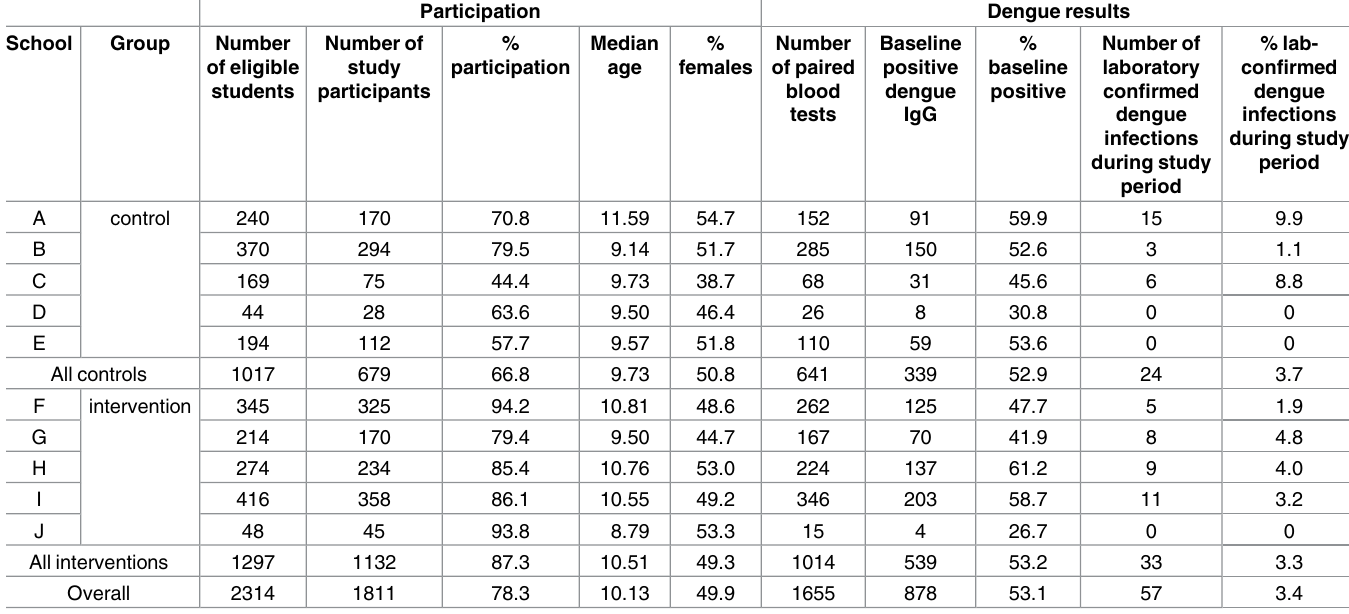
Table 1. Proportions of dengue infections in 1,655 Thai school children with paired serum samples at 10 schools randomised to insecticide- treated school uniforms (intervention) or untreated school uniforms (control).